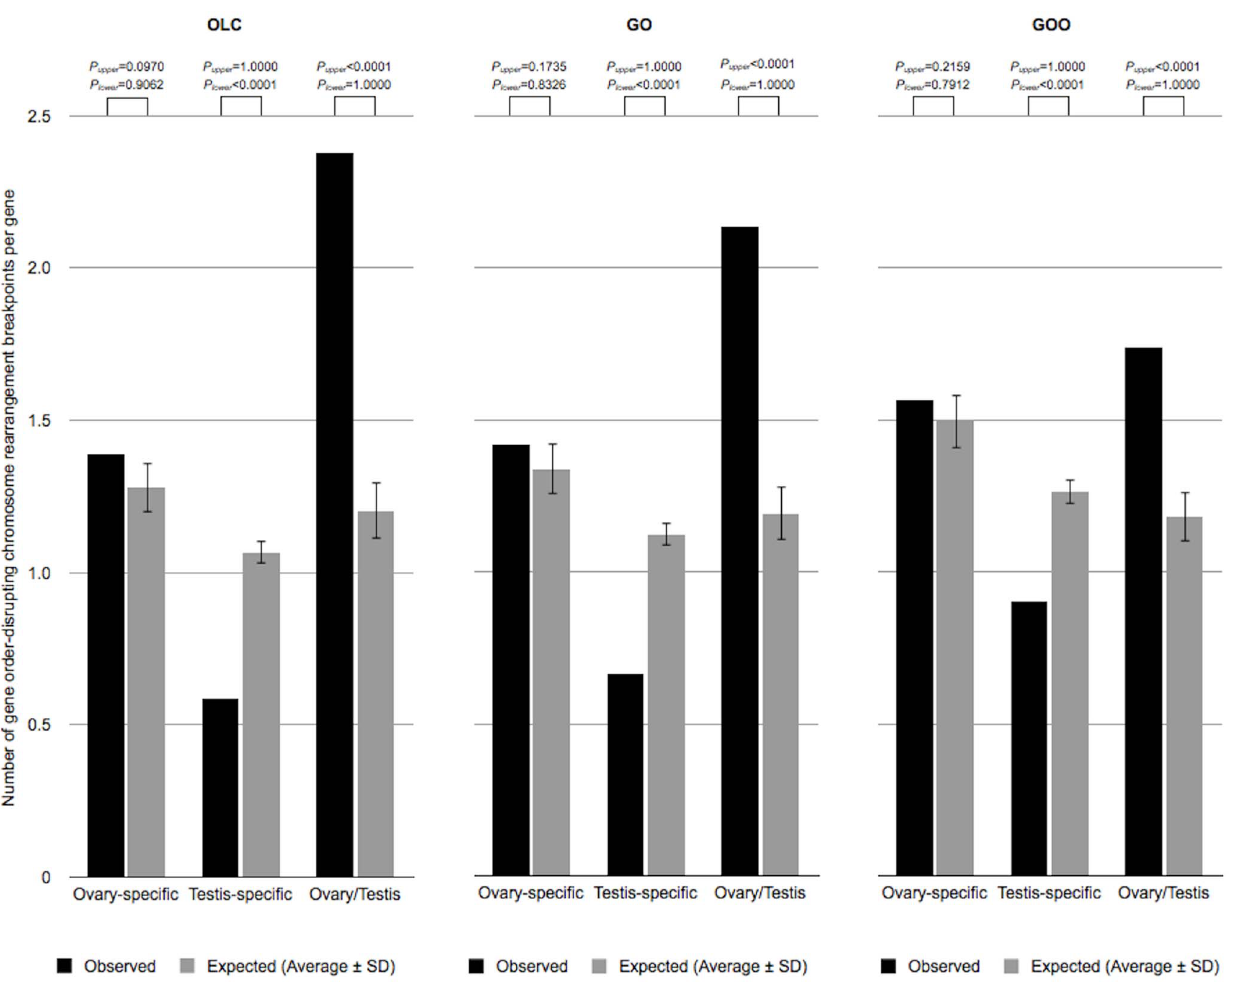
Figure 2. Association between gene order disruption and gonadal gene expression. The association of gene order-disrupting chromosome rearrangement breakpoints with ovary- and testis-specific genes was studied according to three reconstructions of Drosophila genus gene order evolution: OLC, GO, and GOO (see main text for definitions). Expected measures were obtained after random permutation of testis- and ovary-specific gene tags, respecting their chromosome arm distribution (10,000 replicates). P upper and P lower values represent the fraction of random simulations with measures larger or equal, and lower or equal than the observed ones, respectively.